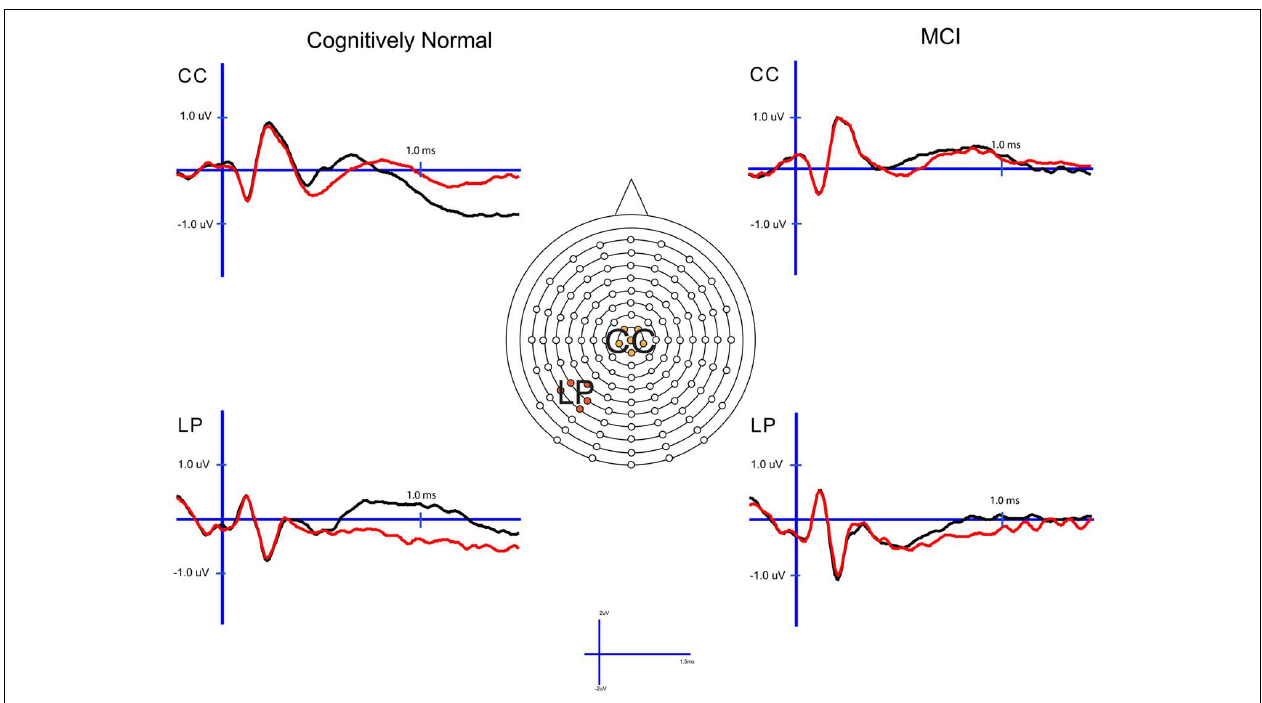
FIGURE 4 | Cognitively normal and amnestic mild cognitive impairment grand average ERP waveforms for studied (black) and unstudied (red) words in the midline central (CC) and left parietal (LP) sites. Studied waves were generated by averaging across the 1 × and 3 × study